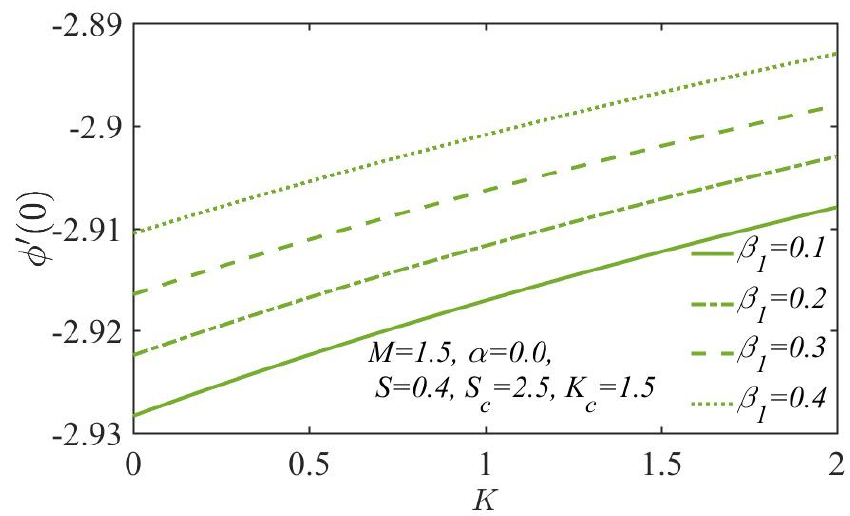
Figure 15. Skin friction coe ffi cient with the fluctuation of β 1 .